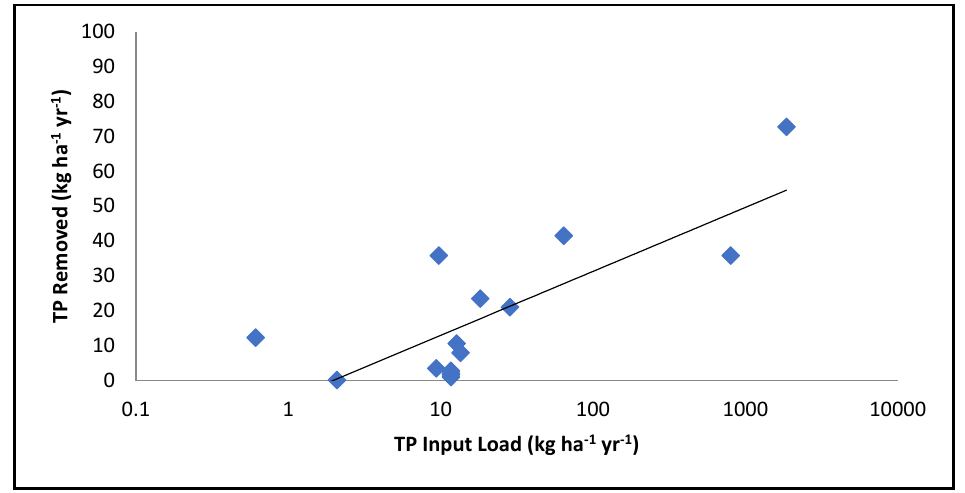
Figure 9. Increase in total phosphorus (TP) mass removed as the TP load increased (y = 0.0326x + 11.936, ρ = 0.63, p = 0.01).